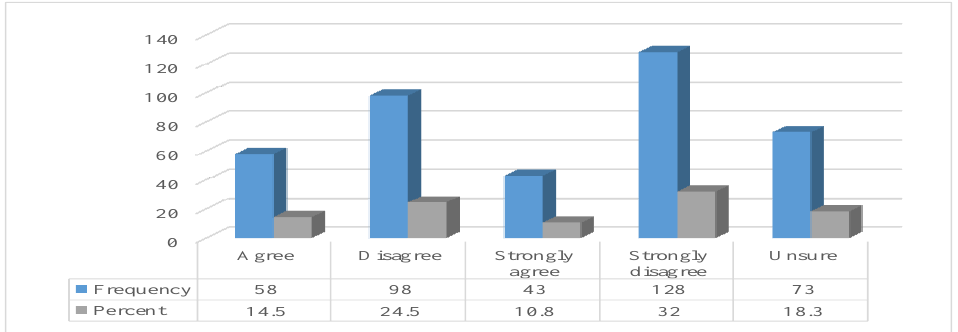
Figure 6: Consultation during annual review; Source :